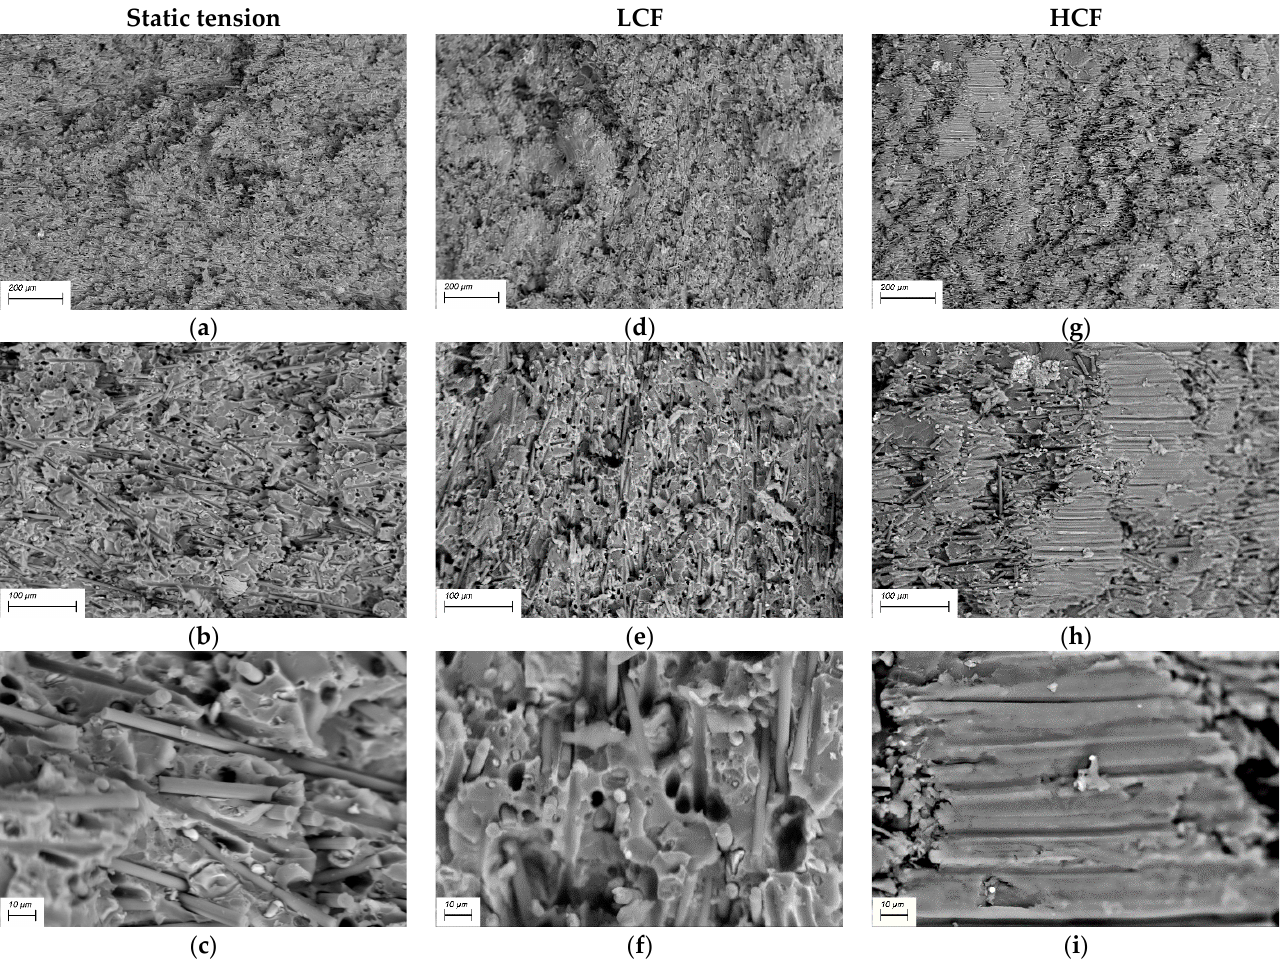
Figure 9. The SEM micrographs of the “PI/PTFE/MCF” composite fracture surfaces: left column— under static tension, middle column—under the LCF, right column—under the HCF: ( a – c ) high degree heterogeneity relief, ( d – f ) signs of fracture by the normal opening mechanisms, ( g – i ) MCF “depleted” regions in on the fracture surface.